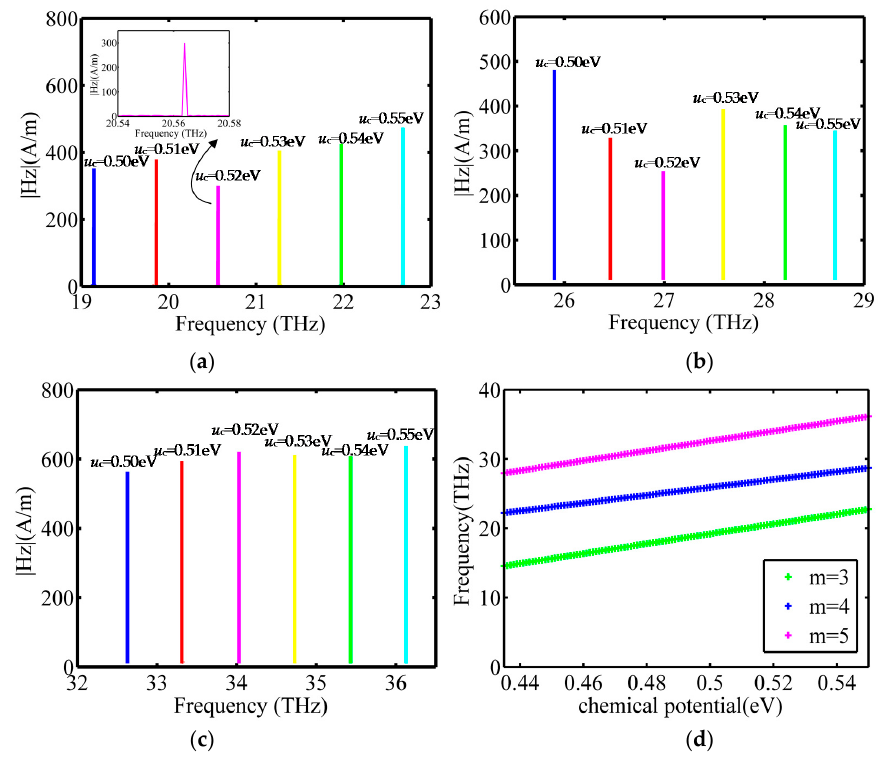
Figure 6. ( a – c ) Resonant frequency spectrum of modes 3, 4, 5 for a variation of chemical potential; ( d ) The relation between resonant frequency and the chemical potential.